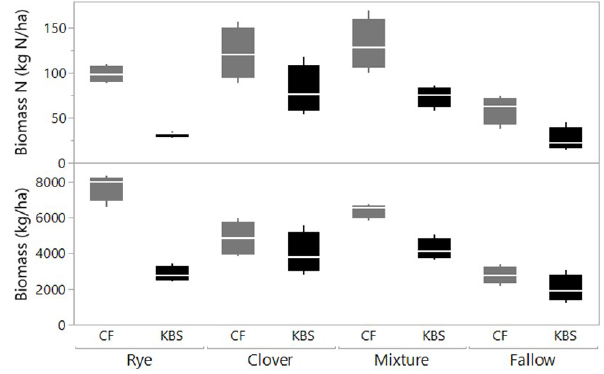
Figure 1. Biomass (kgha − 1 ) and biomass N (kgNha − 1 ) by treat- ment (including cover crops and weeds) at two sites (CF and